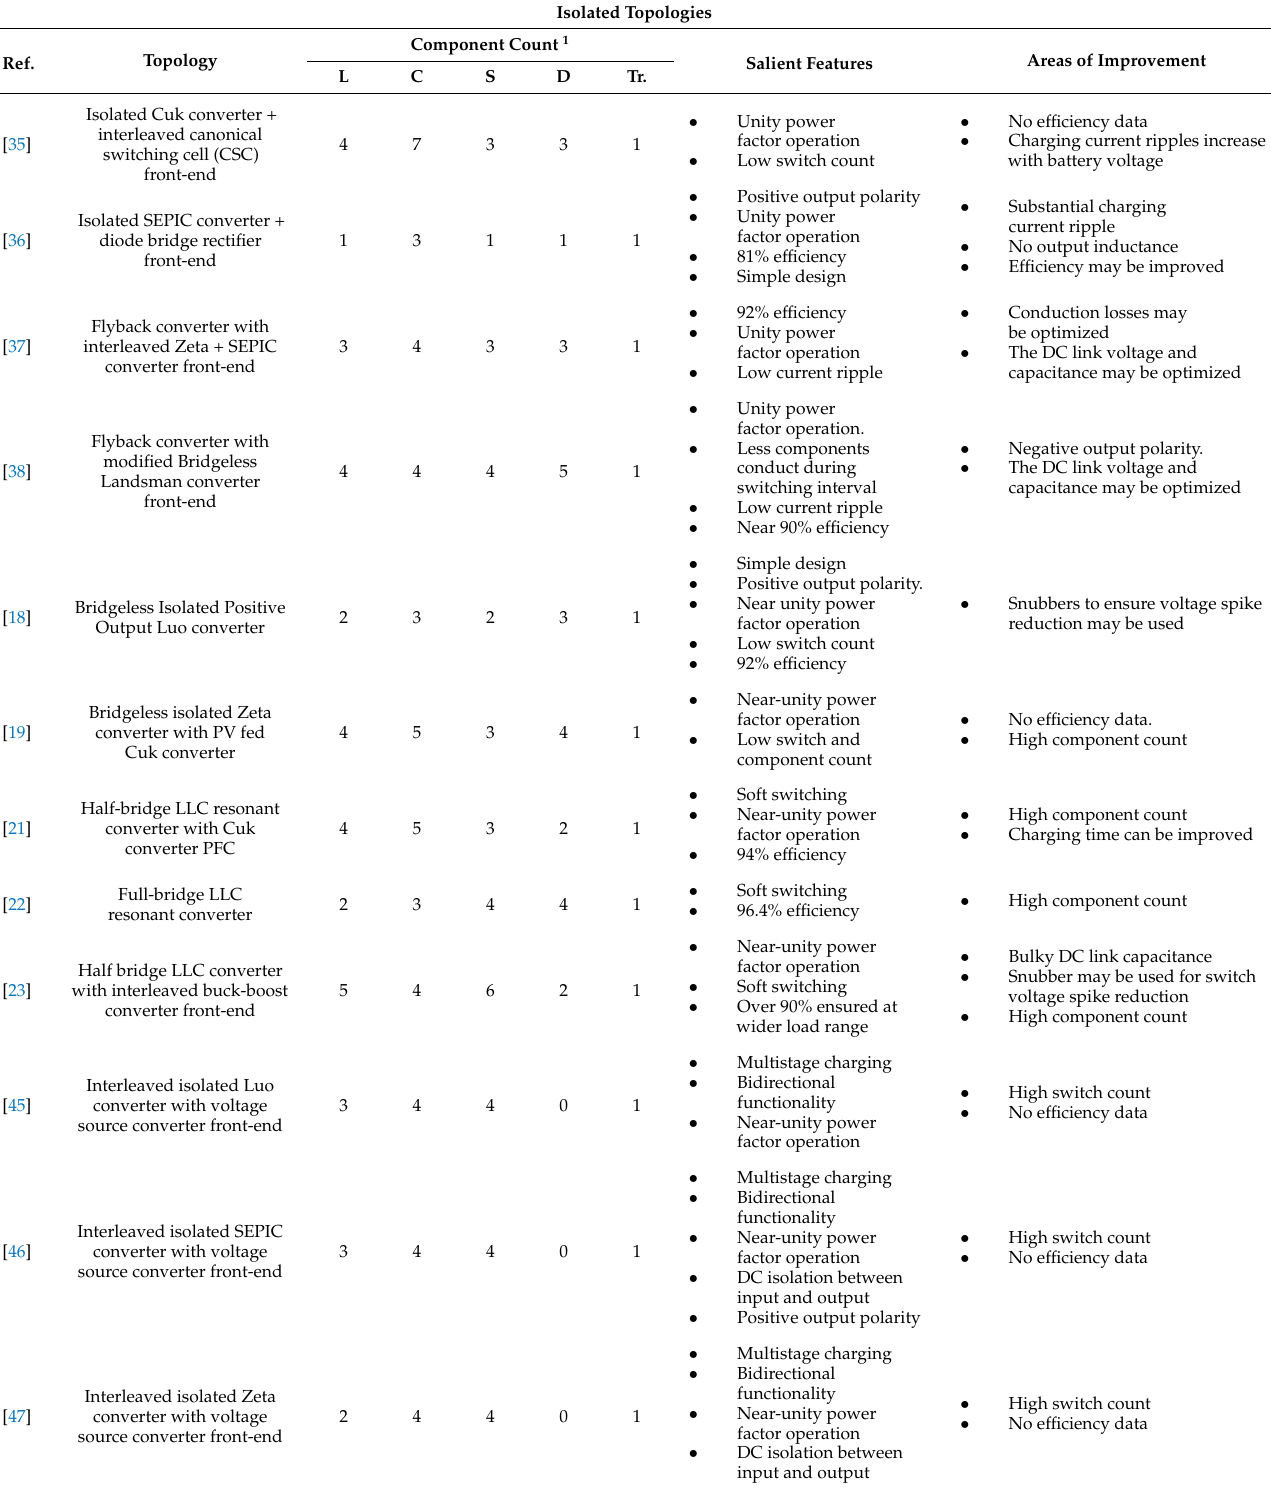
Table 2. Summary of on-board charger DC-DC